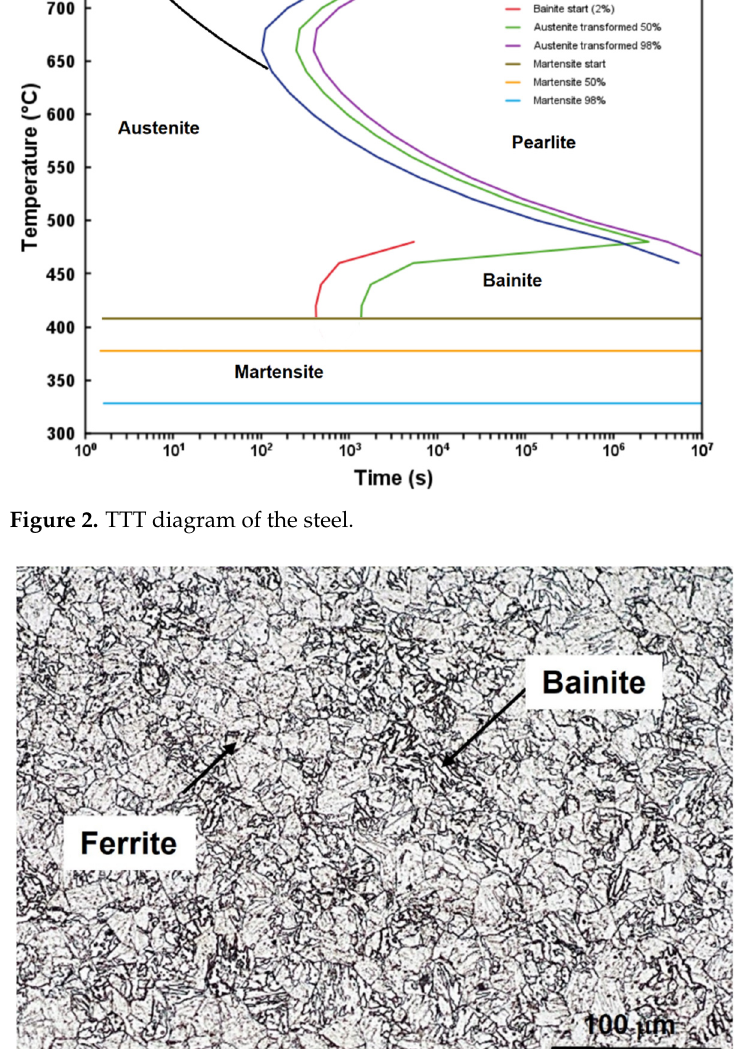
Figure 2. TTT diagram of the steel.